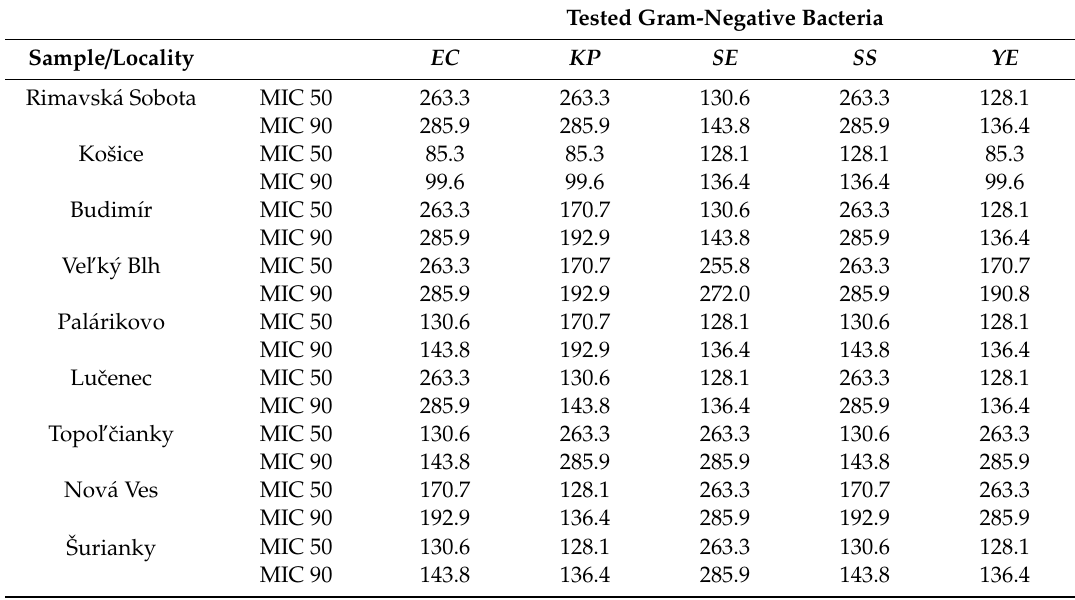
Table 5. Minimal inhibition concentration of Ginkgo biloba L. ( µ g / mL) for Gram-negative bacteria. Tested Gram-Negative